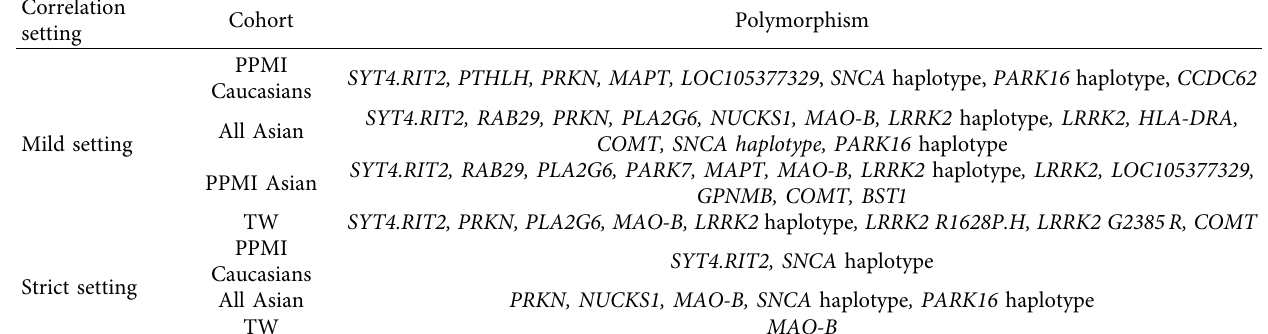
Table 5: Summary of polymorphisms correlated with PD progression among diverse populations.